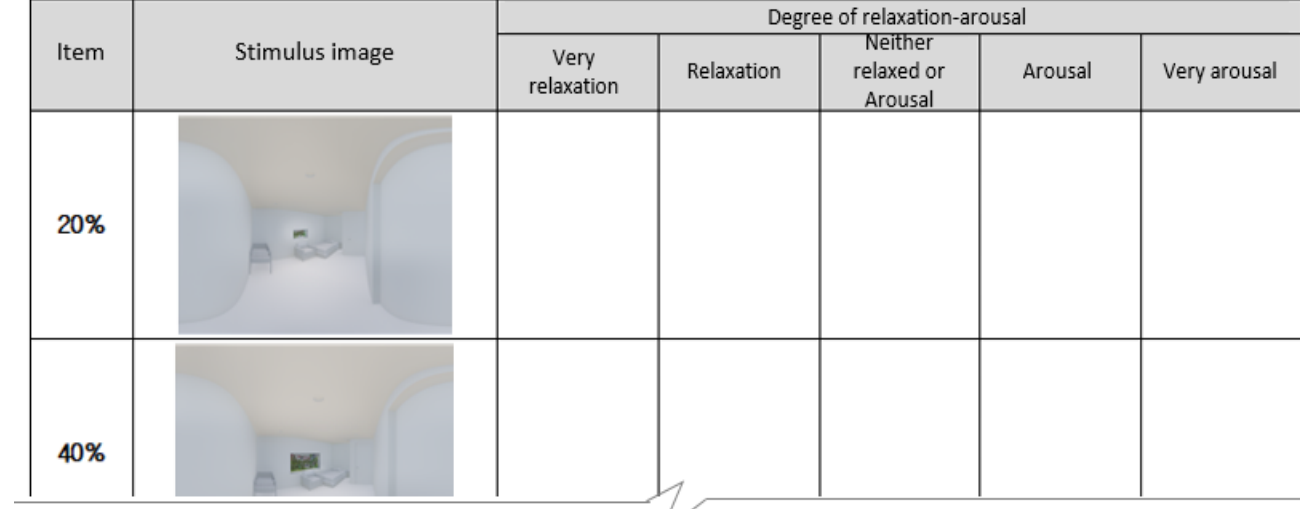
Figure 8. Relaxation-arousal questionnaire.